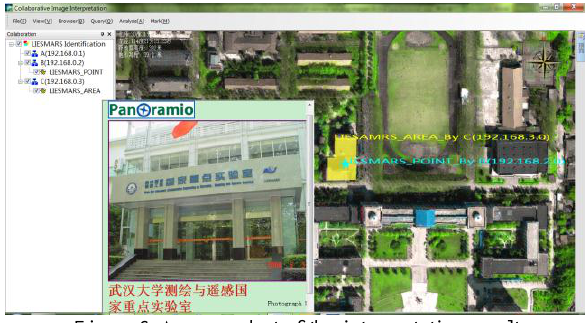
Figure 6. A screenshot of the interpretation